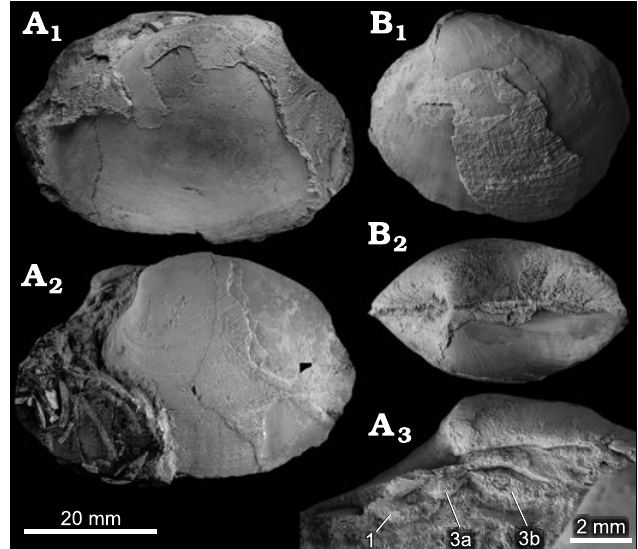
Fig. 15. The vesicomyid bivalve Wareniconcha sp. from Upper Miocene seep deposits of the Amlang Formation in Pangasinan province, Luzon, Philippines. A . NRM Mo 192537, large, slightly disarticulated specimen, view on RV (A 1 ), view on LV and RV hinge plate (A 2 ), and close-up on RV hinge with cardinal teeth numbers indicated (A 3 ). B . NRM Mo 192538, articulated, medium-sized specimen, view on LV (B 1 ) and on dorsal side showing inflation and lack of lunular incision (B 2